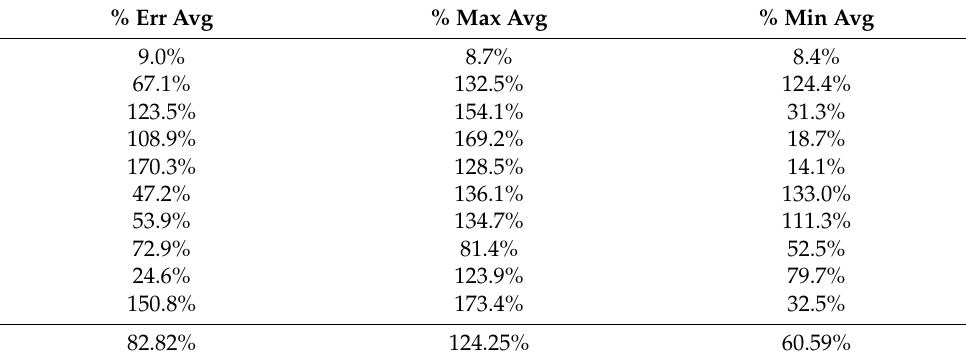
Table A26. Set 1, trials 11–20 data (actual PR